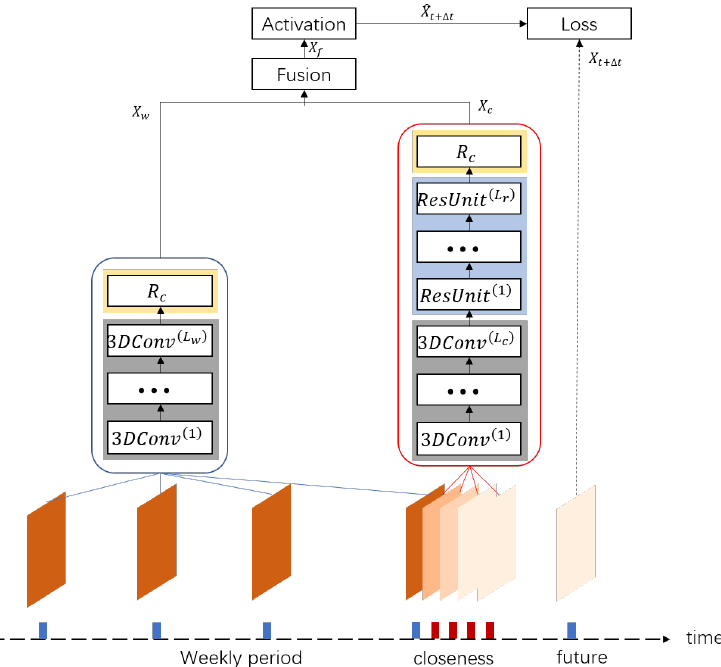
Figure 1. ST-3DNet structure. 3D Conv, Resunit and Rc denote 3D Convolutional, residual unit and Recalibration block,